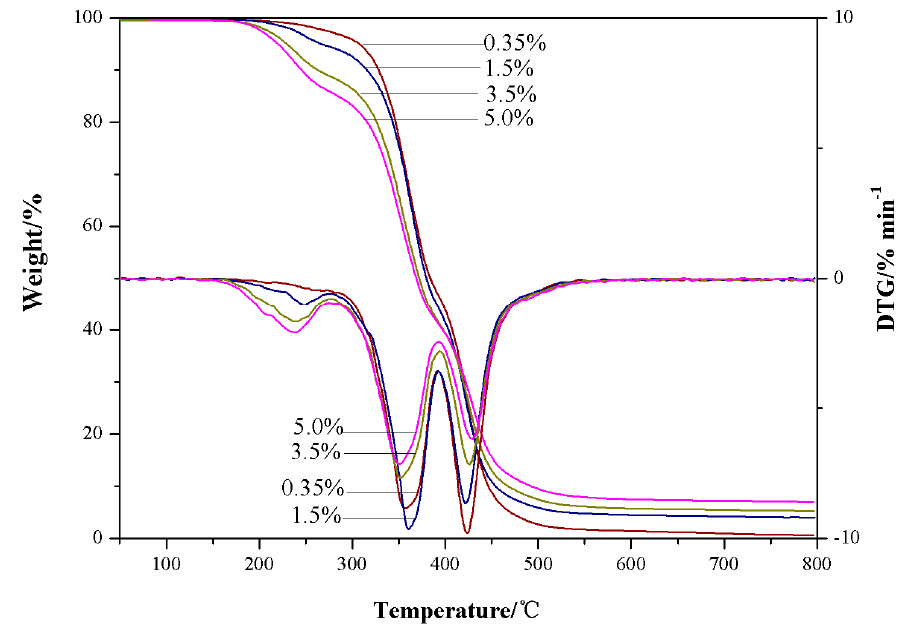
Figure 4. TGA thermograms and derivatives of 0.35%, 1.5%, 3.5%, and 5.0% GO-TBPU in nitrogen.